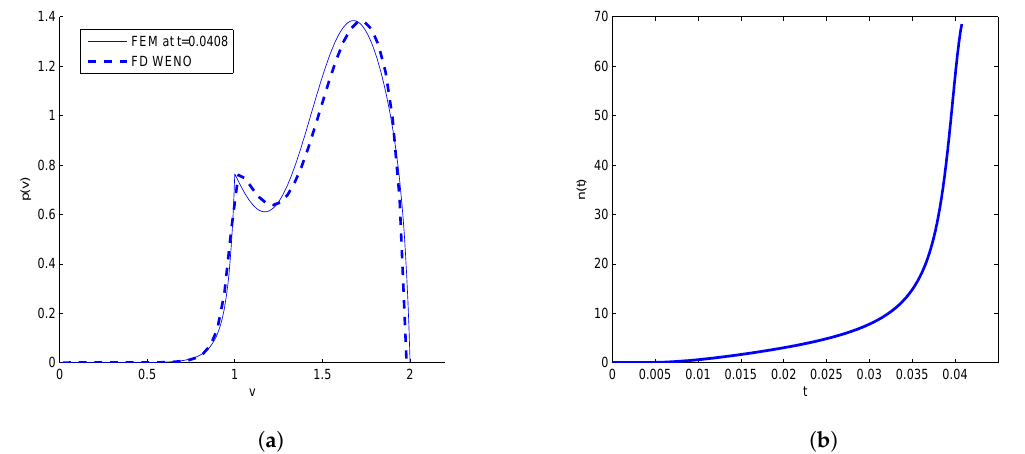
Figure 3. Left: The approximate solution p ( v , t ) , Right: Firing rate N ( t ) for initial data given in = 0.005. The system is considered for the excitatory Equation (20) with mean v 0 = 1.5 and variance σ 2 0 case i.e., by taking b = 1.5 > 0 with activity dependent noise a ( N ( t )) = a 0 = 1. ( a ): Comparison of the existing scheme and FEM for the numerical Solution p ( v , t ) ; ( b ): Time evolution of the firing rate N ( t )